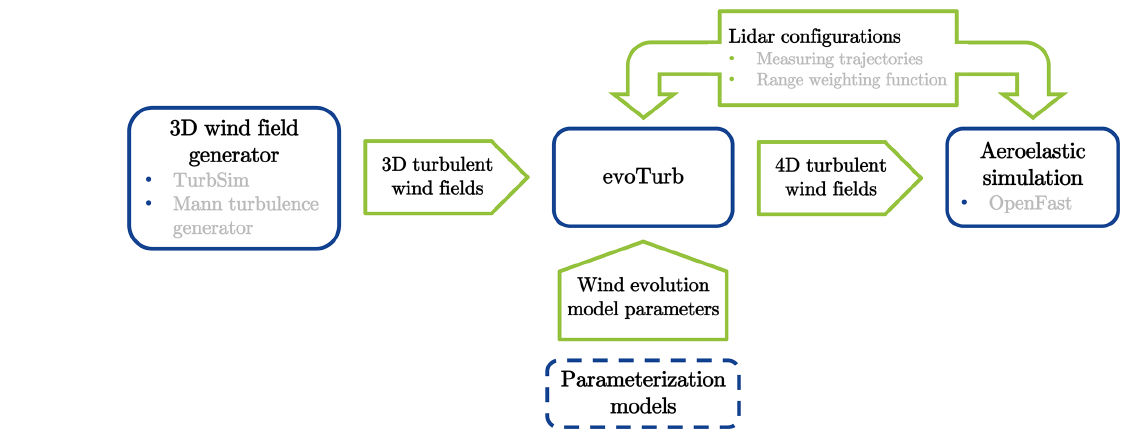
Figure 2. Concept for integrating the 4D wind field simulator evoTurb into the aeroelastic simulation of wind turbines.